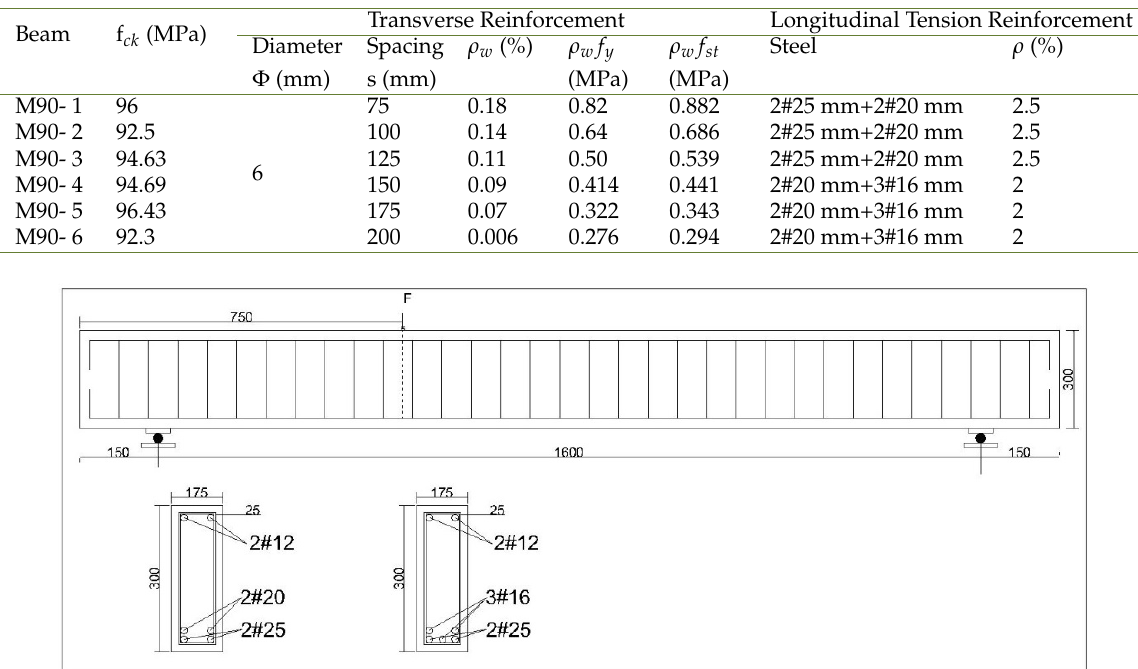
Fig. 2. Details of